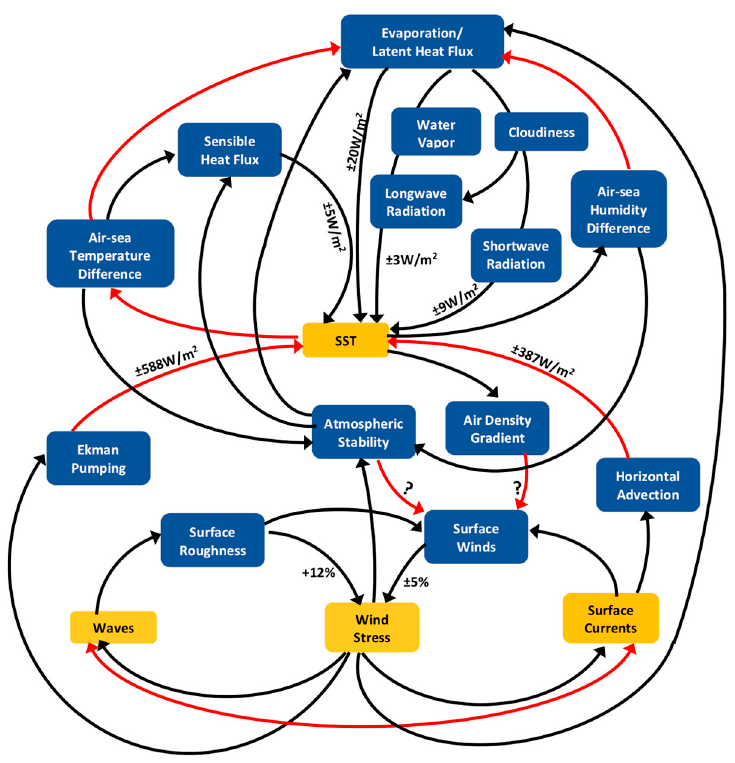
Figure 15. A schematic diagram of the feedback mechanism in coupling ocean currents, waves, and wind stress, simultaneously. All numbers are a median value of 30 days, averaged difference between CUR_WAV and CTL over the Gulf Stream.